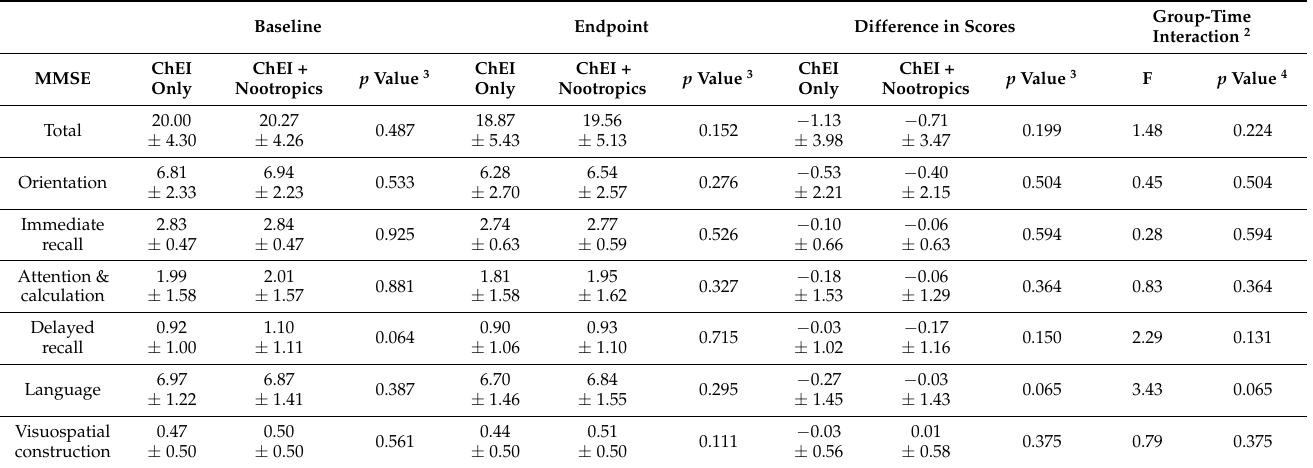
Table 2. Results of significance testing and mixed model analyses for mini mental state examination (MMSE): Cholinesterase Inhibitor Only vs. Cholinesterase Inhibitor and Nootropics Combination 1